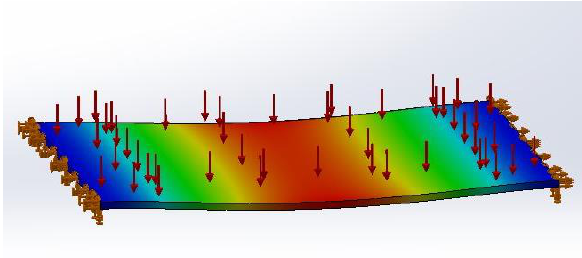
Figure 3. Example of the pressure application to the T2i100 plate and its resulting deformation in SolidWorks simulation.